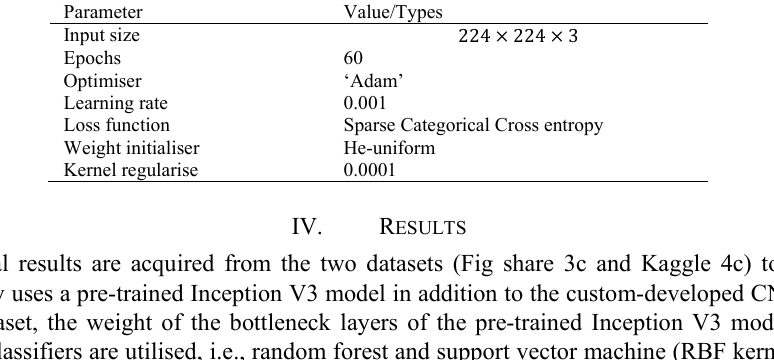
TABLE 4 T RAINING P ARAMETER C